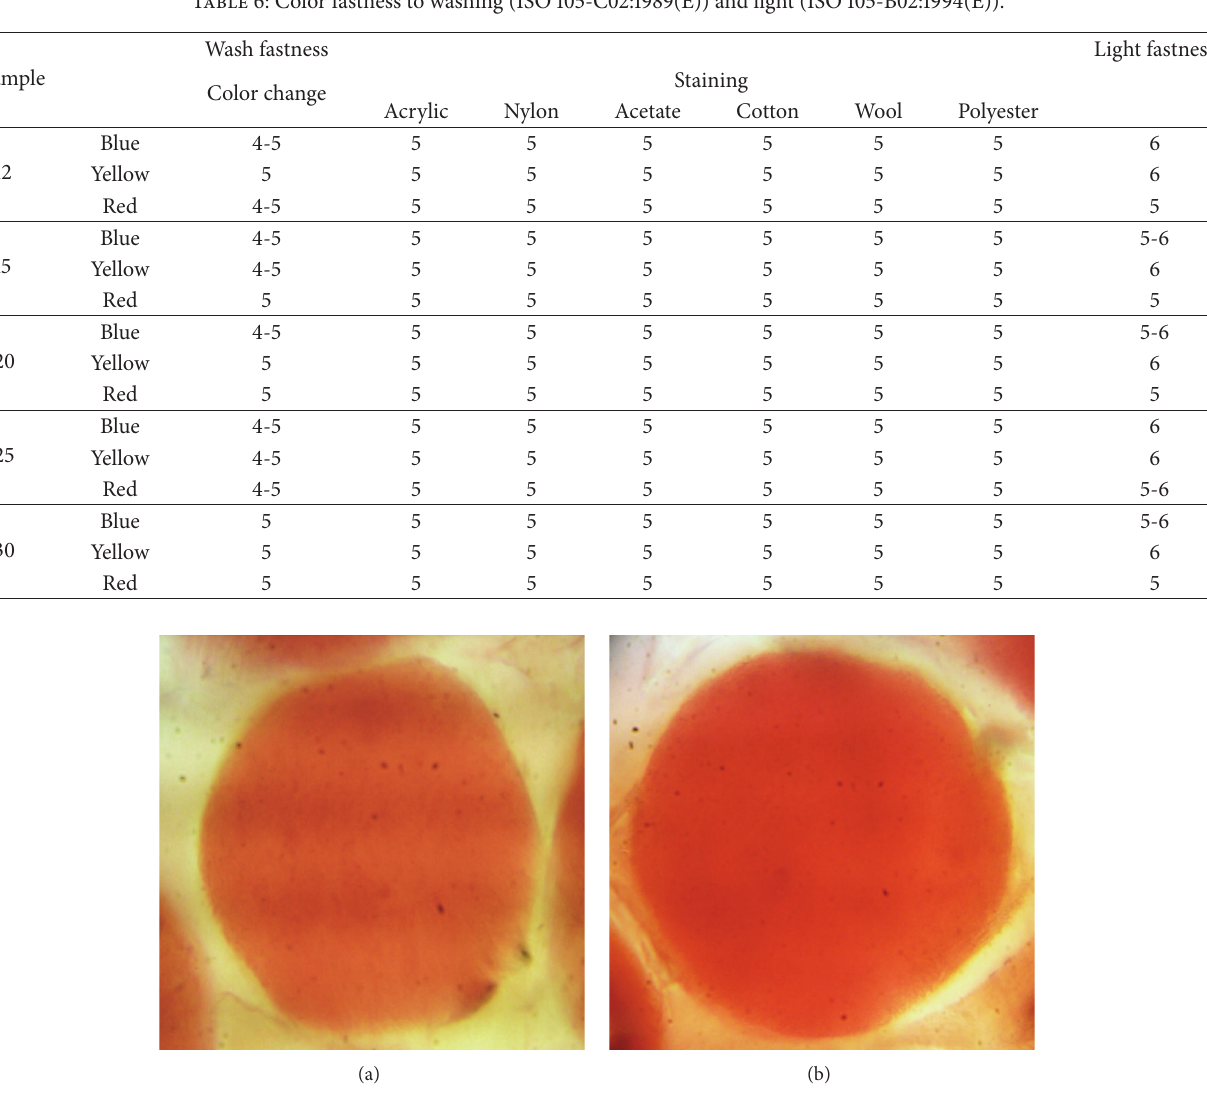
Table 6: Color fastness to washing (ISO 105-C02:1989(E)) and light (ISO 105-B02:1994(E)).